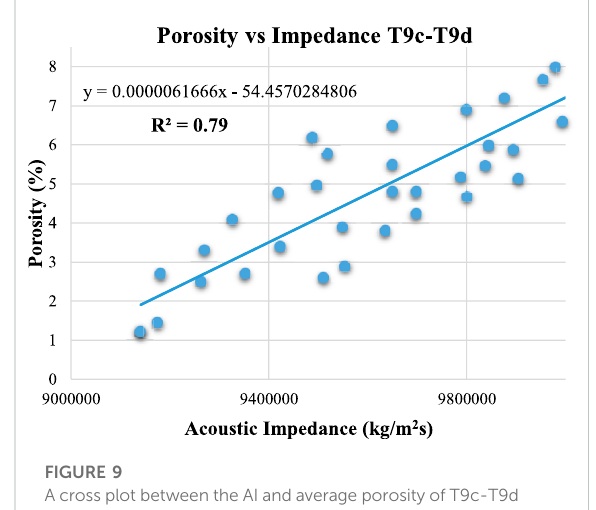
FIGURE 9 A cross plot between the AI and average porosity of T9c-T9d horizons shows a positive slope trend line.